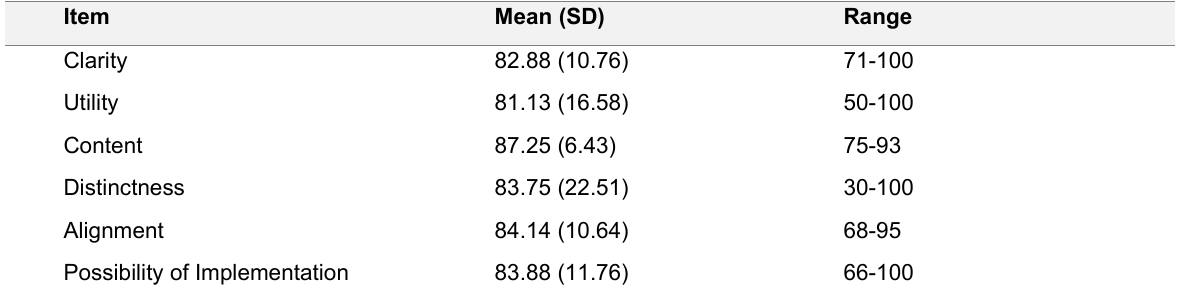
Quantitative Ratings from the Expert Review